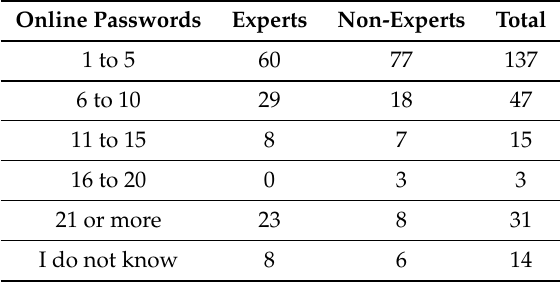
Table 17. Number of Passwords for 128 Experts and 119 Non-experts.